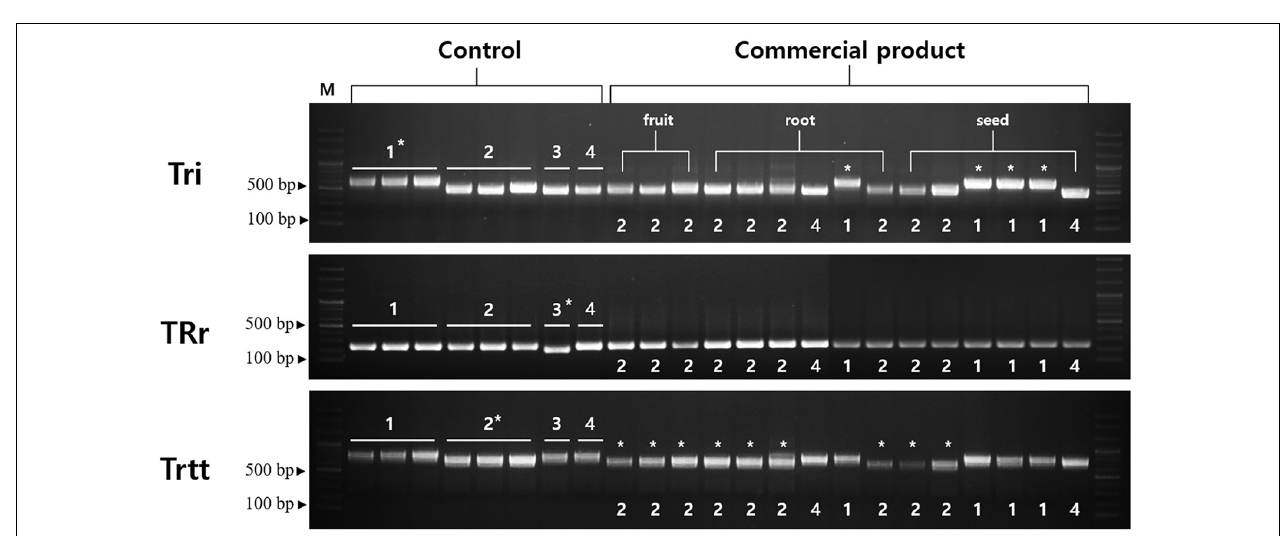
FIGURE 6 | Gel images of indel markers for Trichosanthes . Primers for Tri, TRr, and Trtt were tested with 15 commercial products on the Korean market. Control samples were used in a marker test ( Supplementary Table 4 ). Information regarding the commercial products is provided in Supplementary Table 5 . An asterisk indicates matching between band patterns of control samples and commercial products. 1, Trichosanthes kirilowii var. kirilowii ; 2, Trichosanthes kirilowii var. japonica ; 3, Trichosanthes rosthornii ; 4, Trichosanthes rubriflos